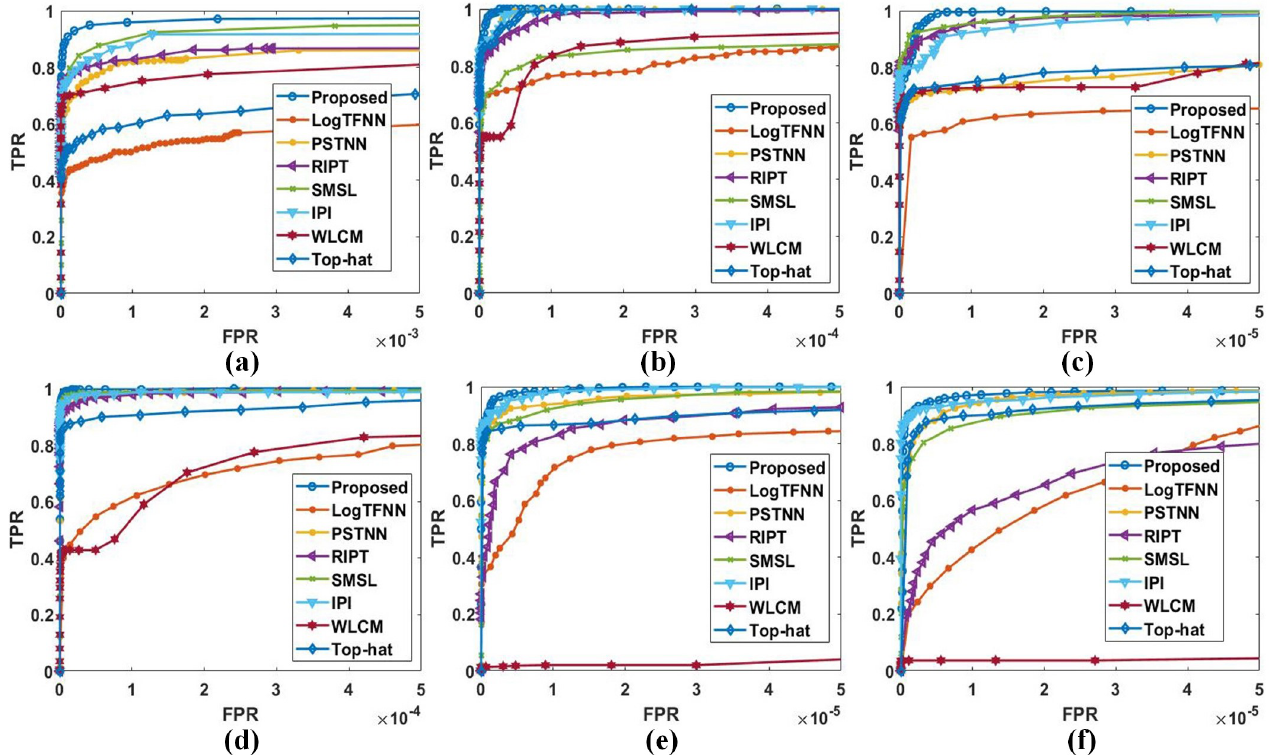
Figure 7. ROC curves for six sequences by comparison methods. ( a ) Sequence 1. ( b ) Sequence 2. ( c ) Sequence 3. ( d ) Sequence 4. ( e ) Sequence 5. ( f ) Sequence